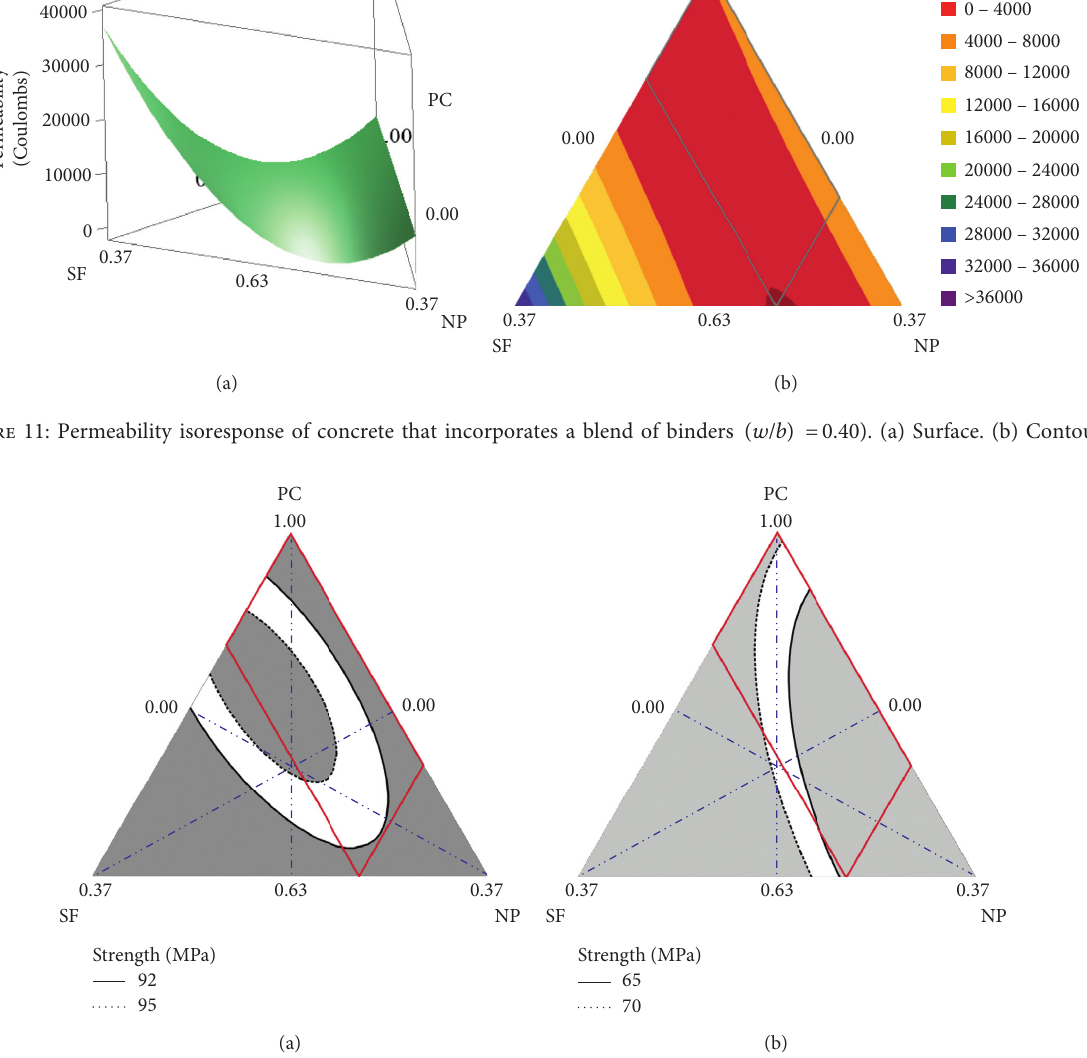
Figure 12: Strength optimization of concrete that incorporates a blend of binders. (a) ( w / b ) � 0.25. (b) ( w / b ) � 0.40.